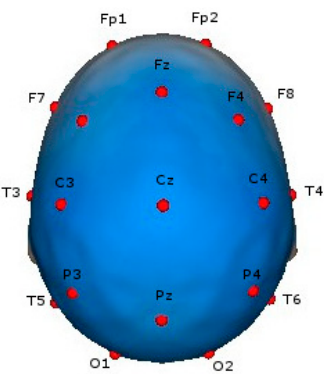
Figure 1. Position of 19 electroencephalogram (EEG) electrodes with referential leads of the International 10/20 System with linked earlobes as references.